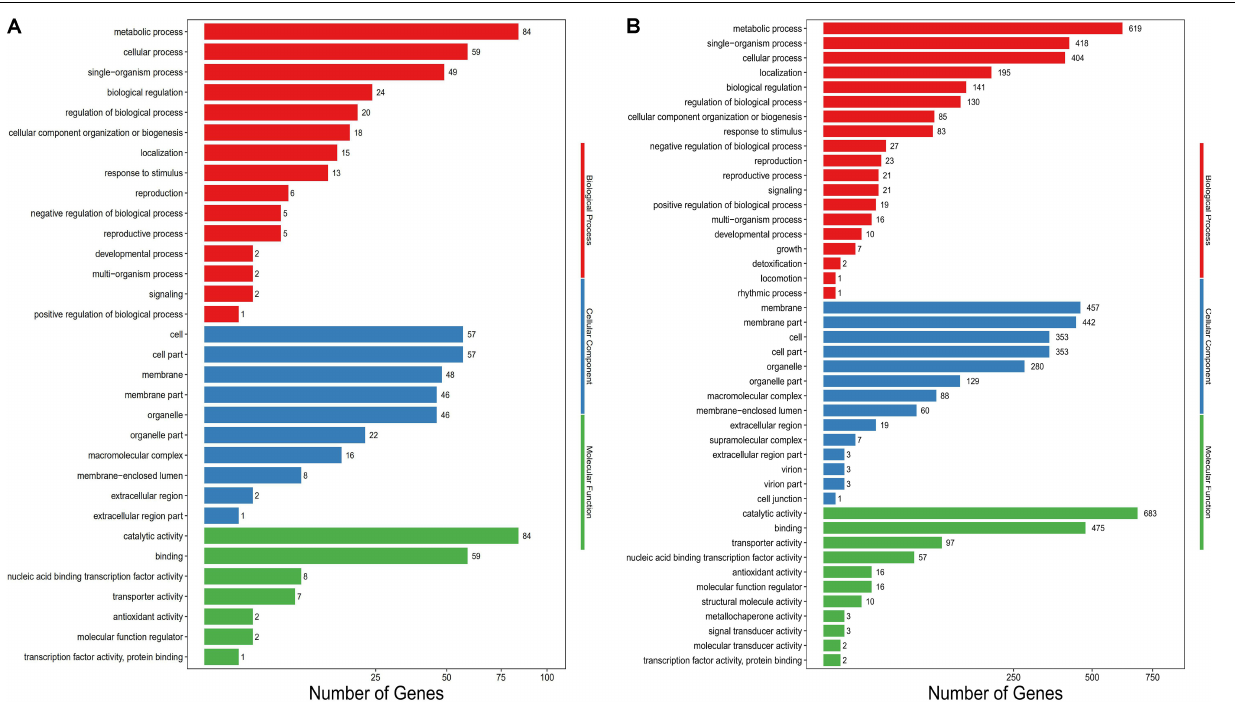
FIGURE 4 | Gene ontology (GO) functional enrichment analysis of the differentially expressed genes (DEG). The X-axis represents the number of DEG, and the Y-axis lists GO terms. (A) G6 vs. F6; (B) G18 vs. F18. G6,G18: G. lozoyensis grown with glucose as carbon source taken at 6 and 18 days; F6,F18: G. lozoyensis grown with fructose as carbon source taken at 6 and 18